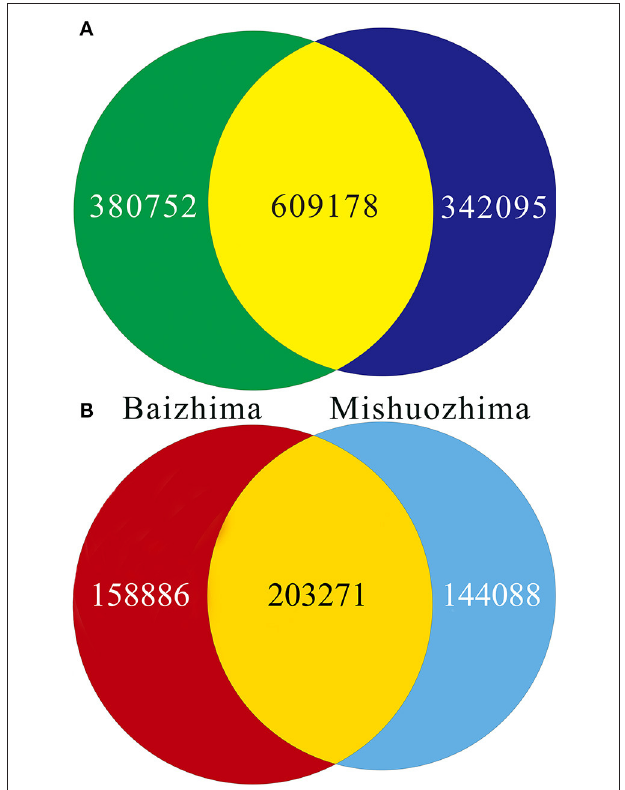
FIGURE 3 | Venn diagrams of SNPs and InDels in genomes of “Baizhima” and “Mishuozhima.” (A) SNPs; (B)